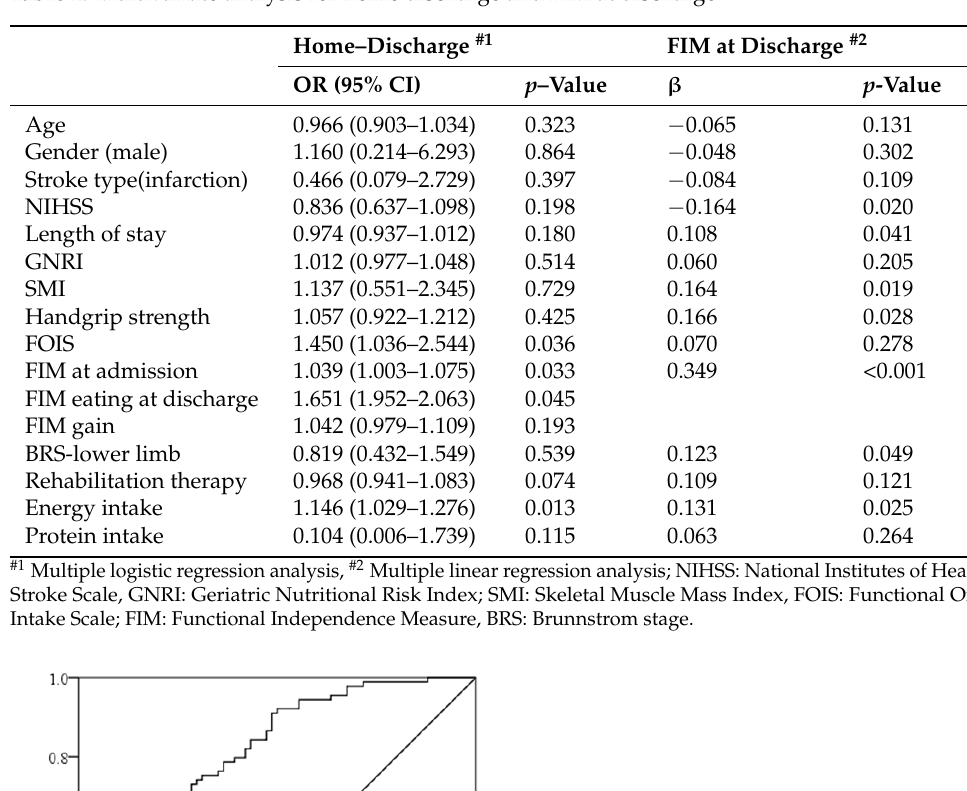
Table 2. Multivariate analysis for home discharge and FIM at discharge.